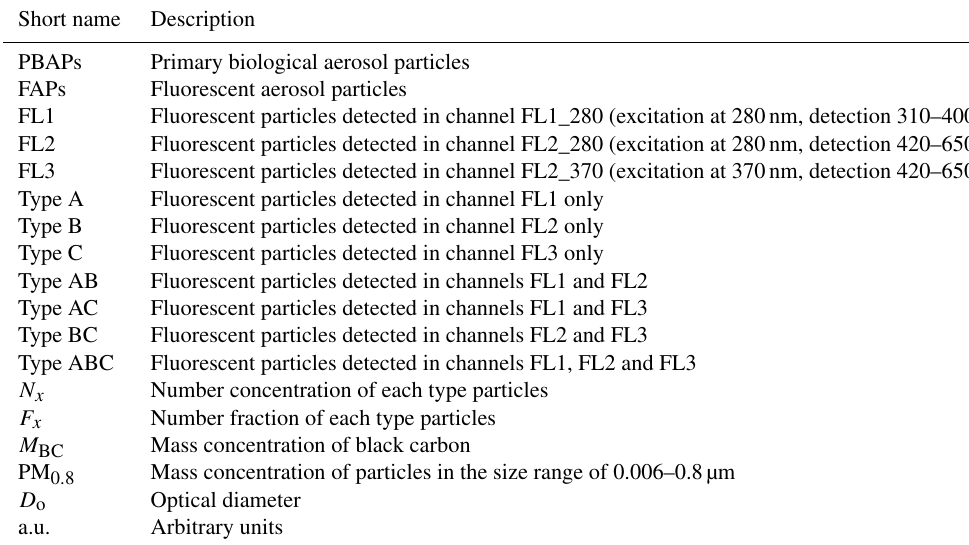
Table 1. Definition of abbreviations used in the